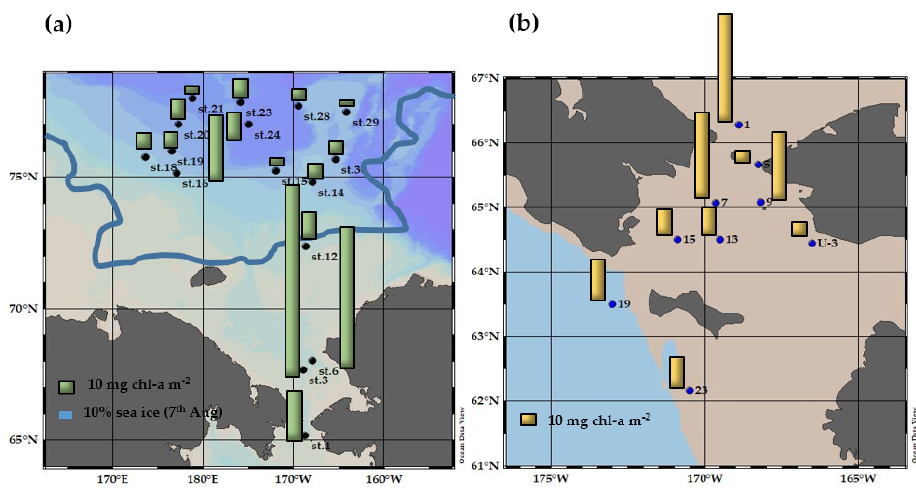
Figure 3. Spatial distributions of column-integrated chlorophyll- a concentration of ( a ) ARA07B and ( b ) OS040.